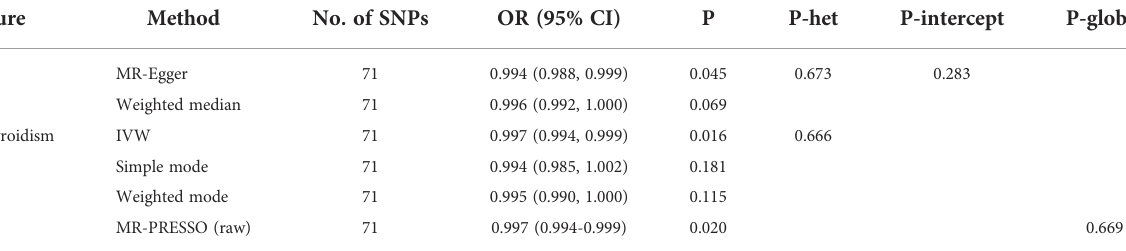
TABLE 1 MR Results of Hypothyroidism on Risk of